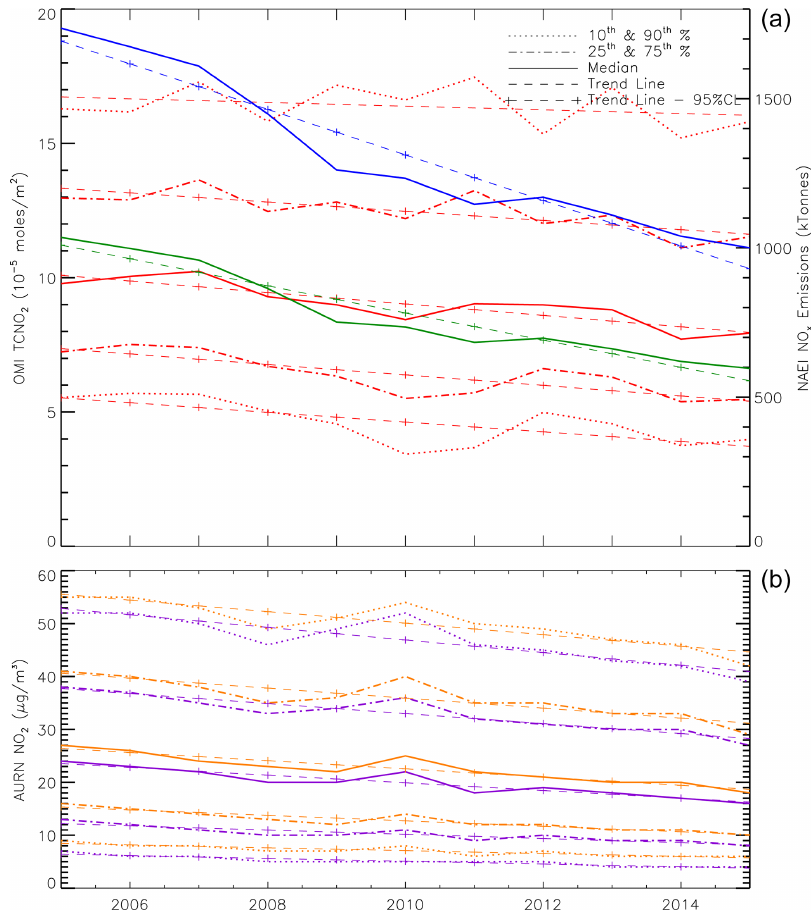
Figure 5. Panel (a) shows time series (2005 to 2015) in OMI TCNO 2 ( × 10 − 5 molm − 2 ) and NAEI NO x emission totals (kt or Gg). OMI median, 10th and 90th and 25th and 75th percentiles are represented by solid, dotted and dot-dashed lines, respectively. NAEI NO x emission totals for the UK and England are represented by the blue and green solid lines. Here, the OMI TCNO 2 has been averaged over England (defined as 3 ◦ W–2 ◦ E, 50–54 ◦ N), and while the UK NO x emission totals are directly reported by the NAEI, the England NO x emission totals have been summed over the emissions maps for the same England definition used for OMI (see Sect. 3.2 for more information). In panel (b) , AURN surface NO 2 (µgm − 3 ) times series are shown for the UK (purple) and England (orange). Trend lines are shown by dashed and dash-crossed lines for insignificant and significant trends (at the 95% confidence